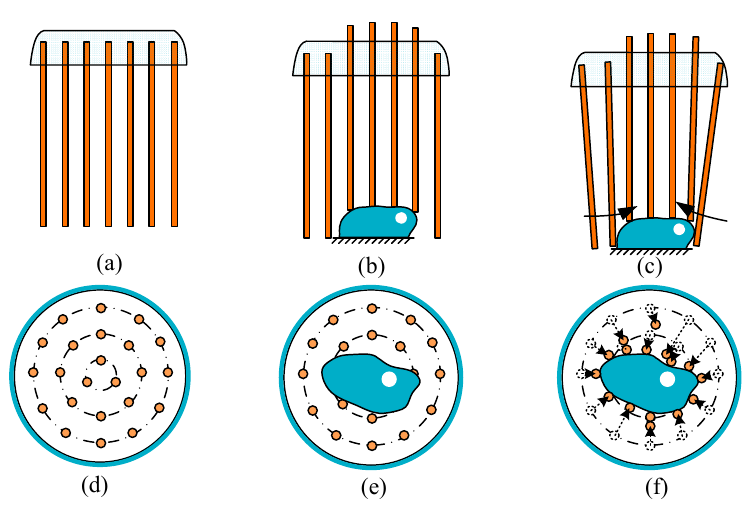
Figure 3. The cluster tube self-adaptive (CTSA) grasping mode.